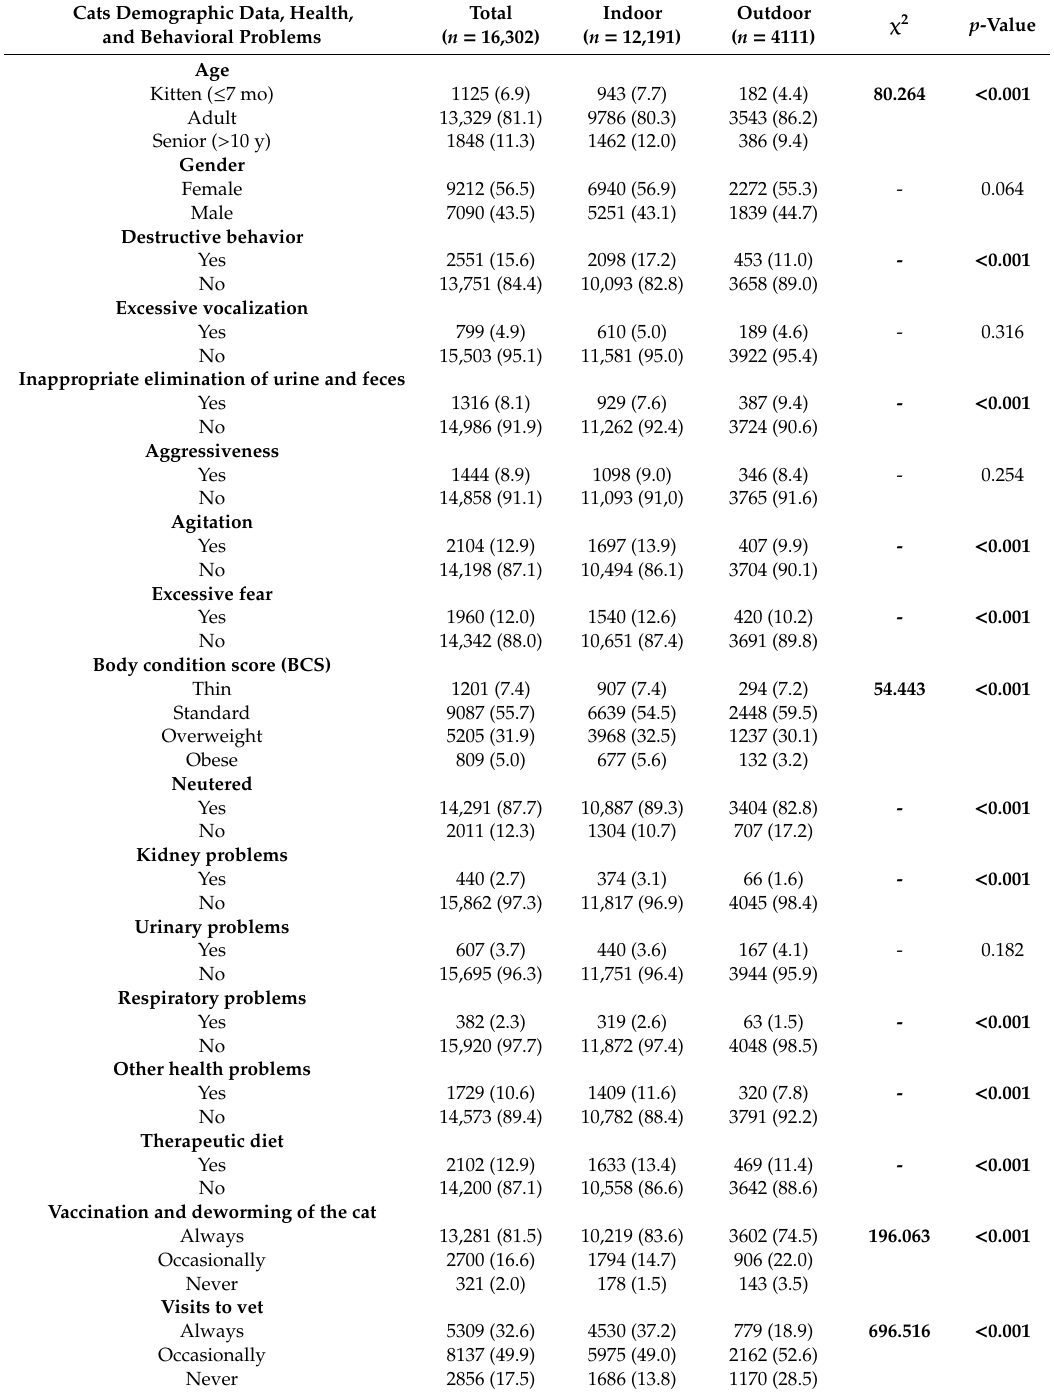
Table 2. Absolute and relative frequencies (%, within parentheses) of health aspects and behavioral problems for the cat population sampled (total) and cats kept indoors and outdoors. Chi-square tests (or Fisher’s exact tests in 2 × 2 table) are shown to test the association between each problem and management type (indoor vs. outdoor). Significant values are shown in